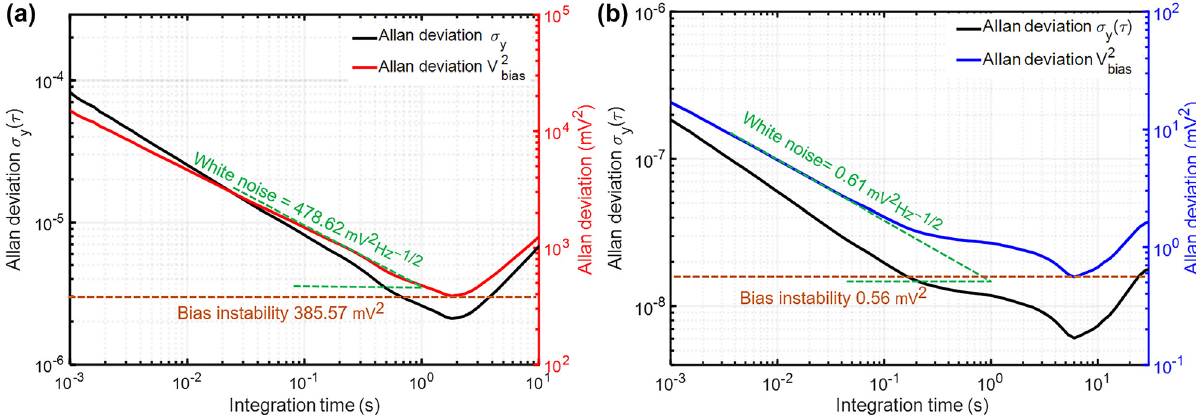
Figure 9: Allan deviation σ y as a function of integration time τ for the optomechanical electrometer operating below and above threshold power without bias voltage applied,